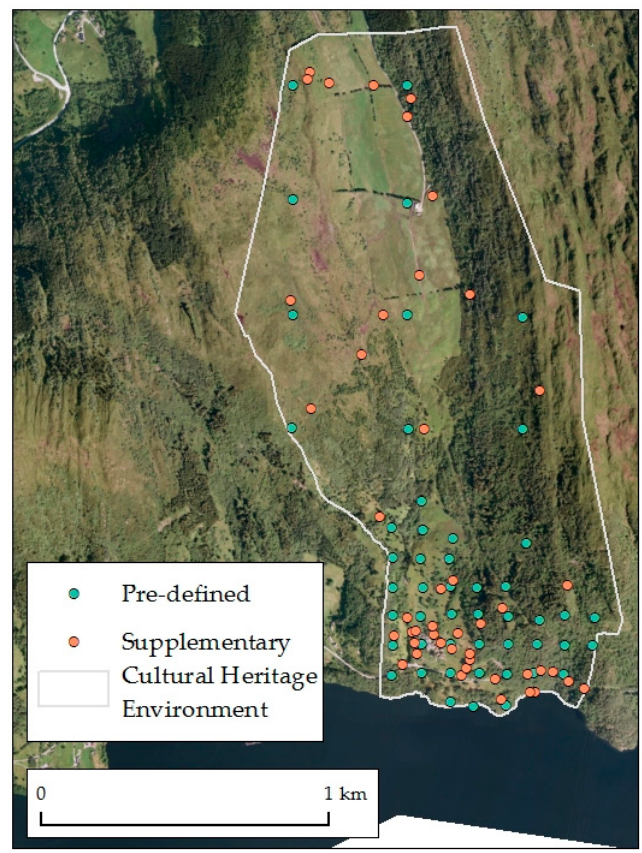
Figure 2. The location of pre-defined (systematic grid) and supplementary photo-points. Aerial photo: https://norgeibilder.no.